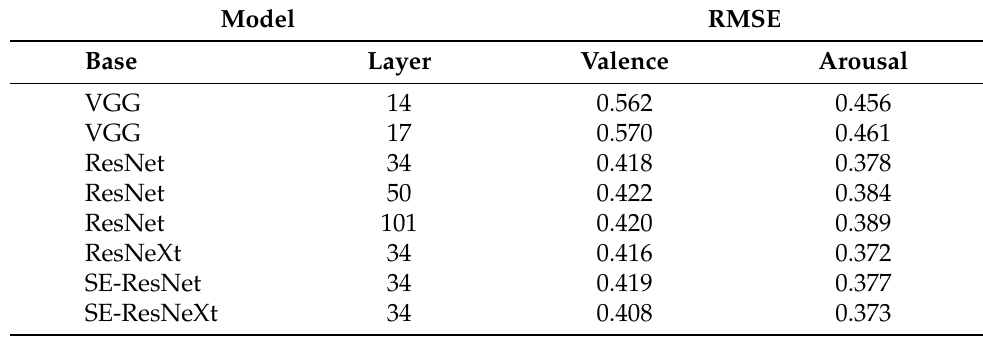
Table 4. RMSE values of valence and arousal on the validation set of the proposed FER.